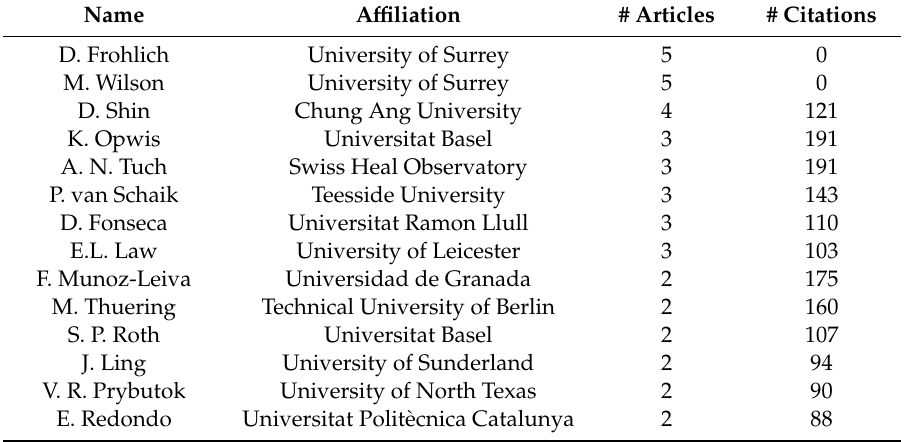
Table 3. Most productive authors. Source: Own elaboration based on WoS.